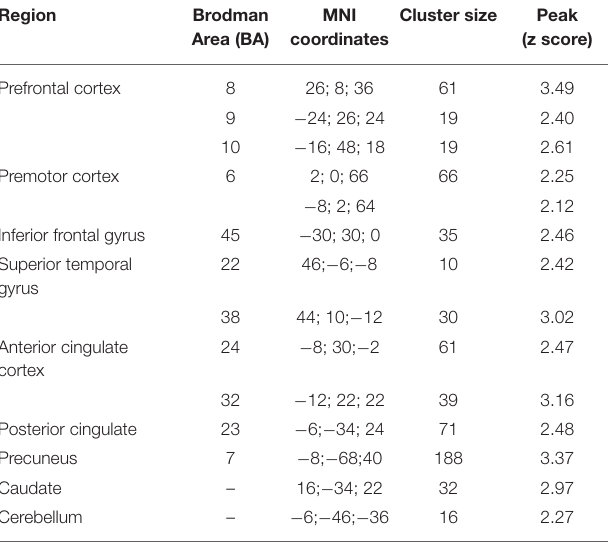
TABLE 3.2 | Main foci of activation for first person sentences in AVI condition contrasted against RW. Region Brodman Area (BA)